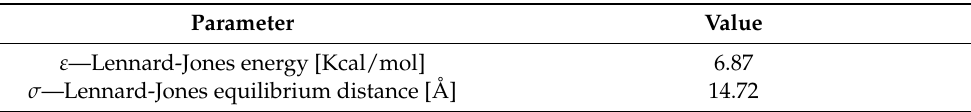
Table 3. Energy parameters of collagen fibril.